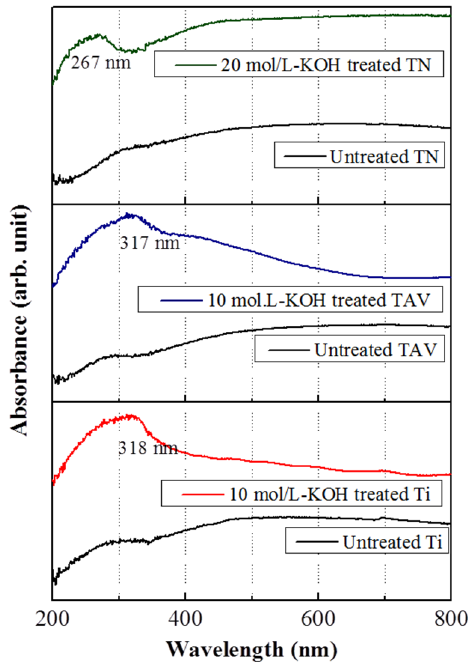
Figure 6. Absorption spectra of the untreated and KOH-treated Ti, TAV and TN substrates. In order to the electronic structure of the obtained nanostructured Ti, TAV and TN series within the same morphology, UV-vis measurements were carried out. A blue shift in the absorption peak was observed after the KOH-treatment in all series due to the quantum size effects in nanostructures. The incorporated K atom induced the rearrangement of the energy levels of the Ti–O components during the formation of the Ti–O–K